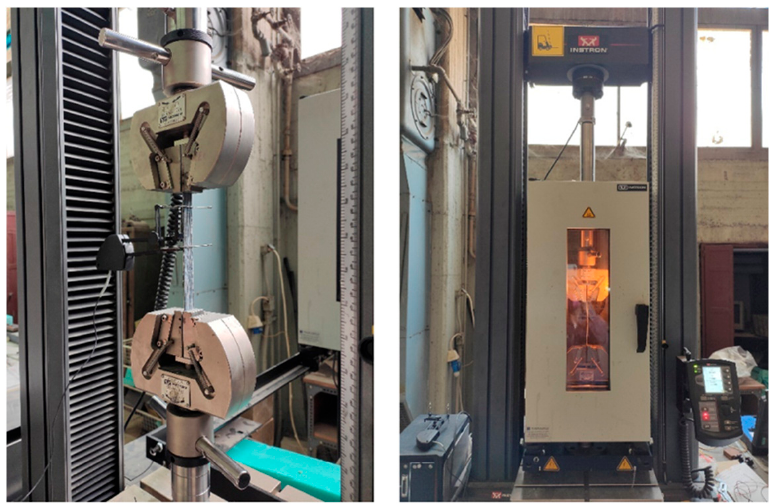
Figure 3. Experimental setup for room temperature and for elevated temperatures.